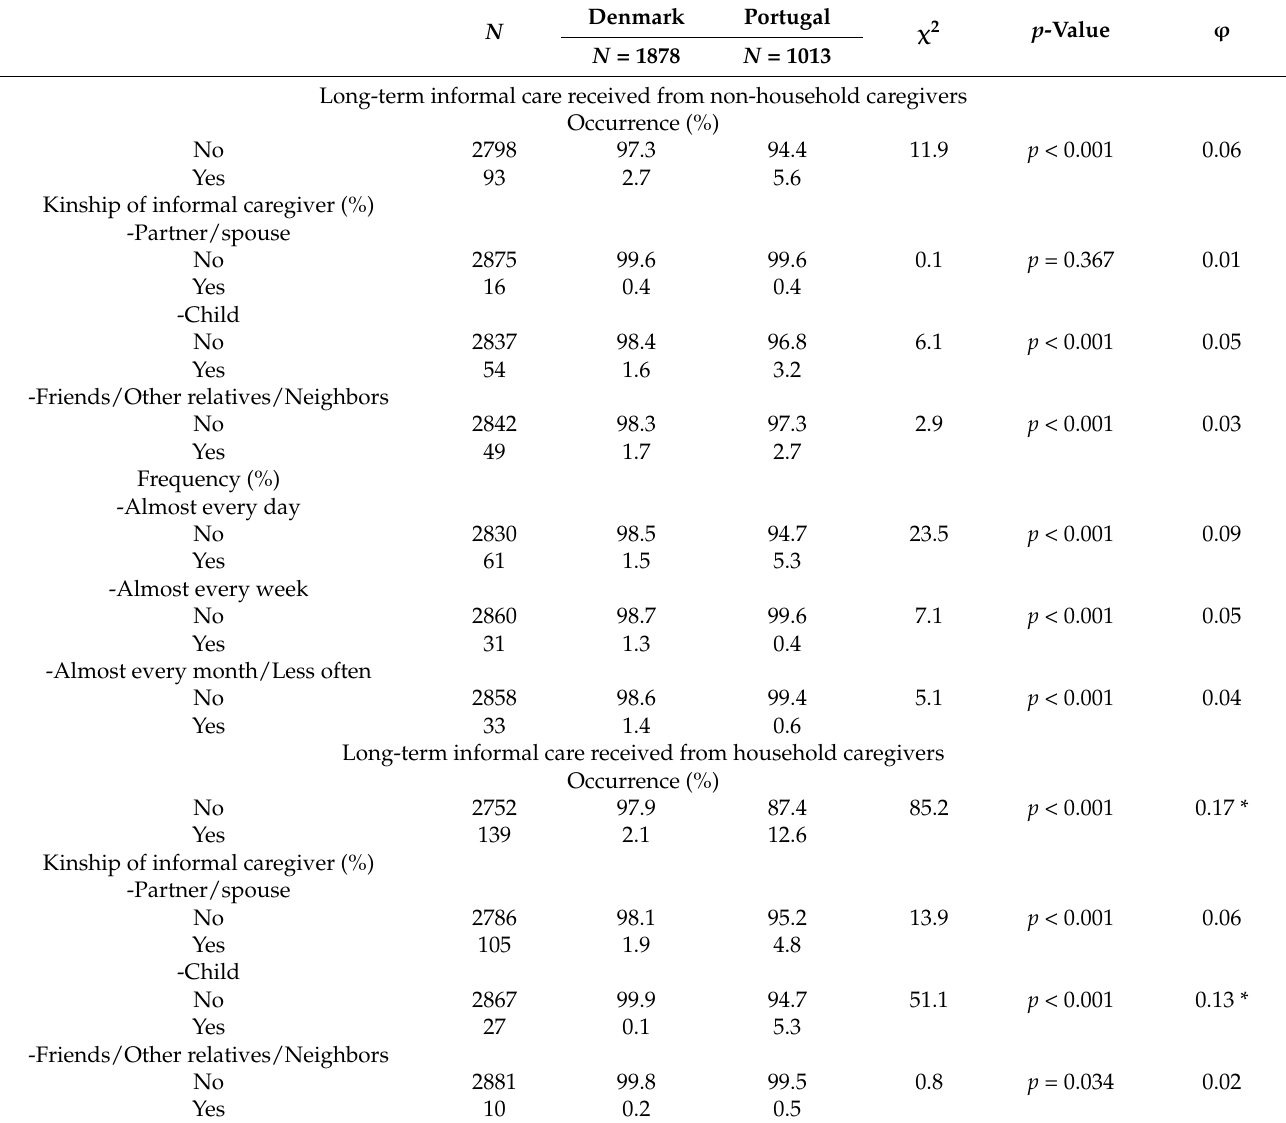
Table 3. Long-term informal care characteristics received by older people, relative to personal care, according to country. Denmark Portugal χ 2 p -Value ϕ N N = 1878 N = 1013